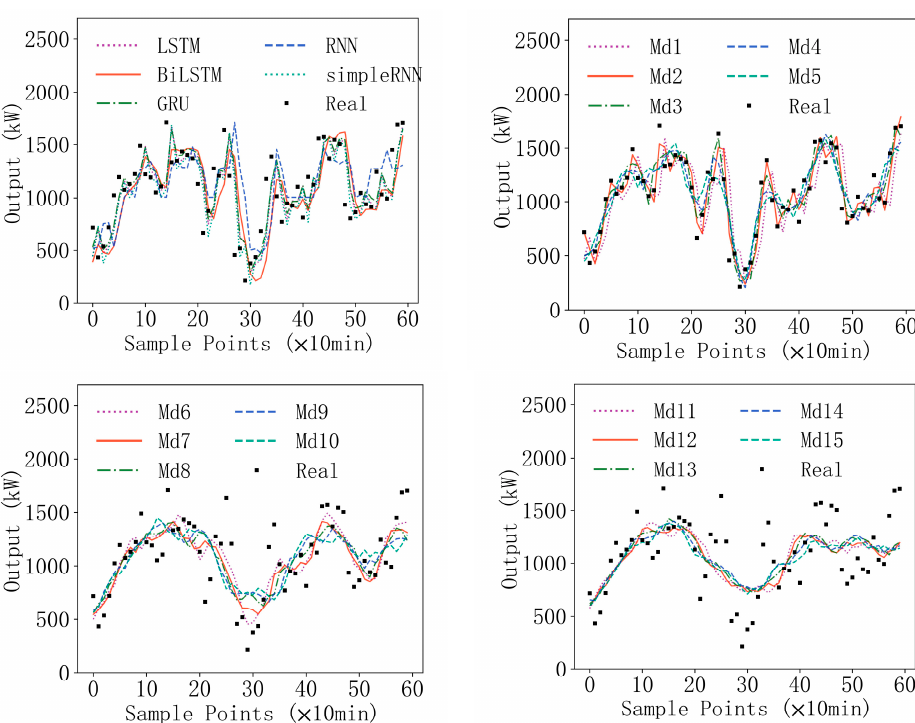
Figure 15. Schematic diagram of power prediction results.